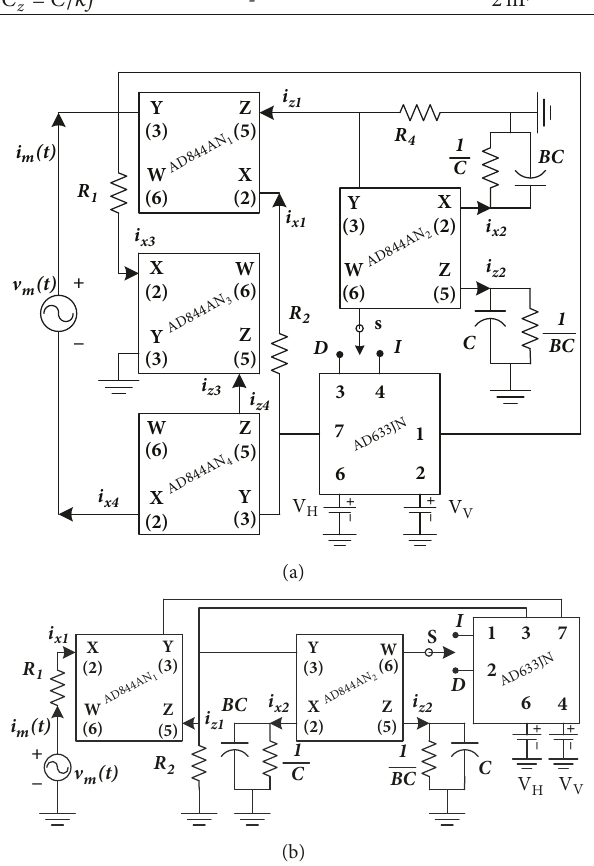
Figure4:(a)Flux-controlledfloatingfracmemristorand(b)charge- controlled grounded